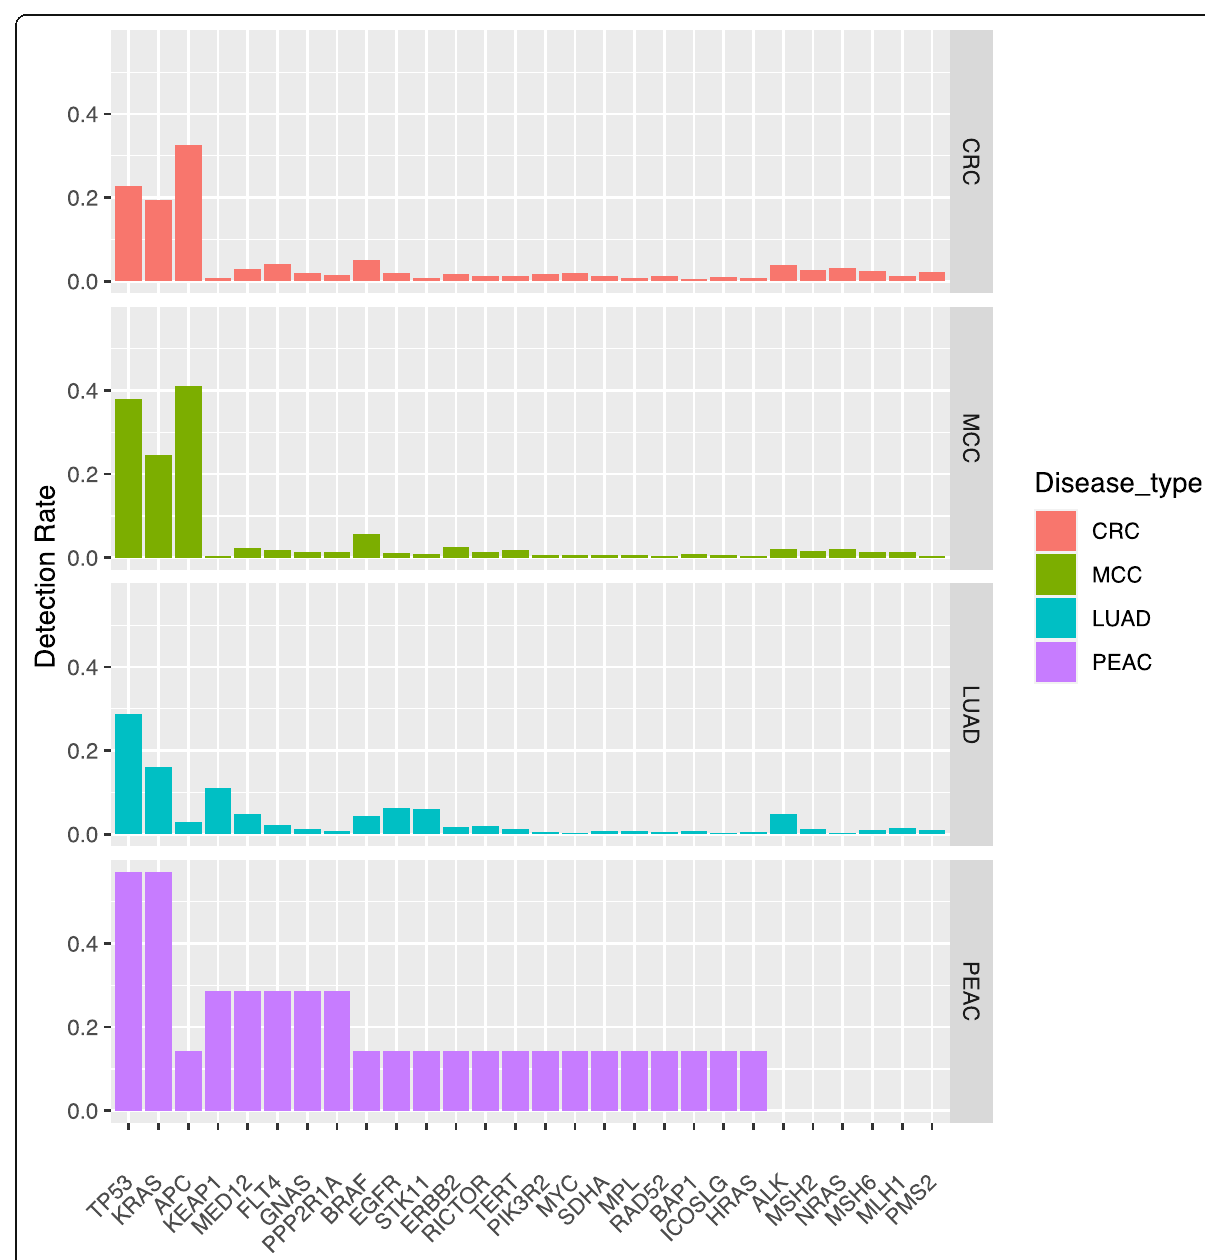
Fig. 2 Detection rate statistics in the PEAC cohort and comparison with TCGA and the MSKCC databases. CRC, colorectal cancer; LUAD, lung adenocarcinoma; MCC, metastatic colorectal carcinoma; PEAC, pulmonary enteric